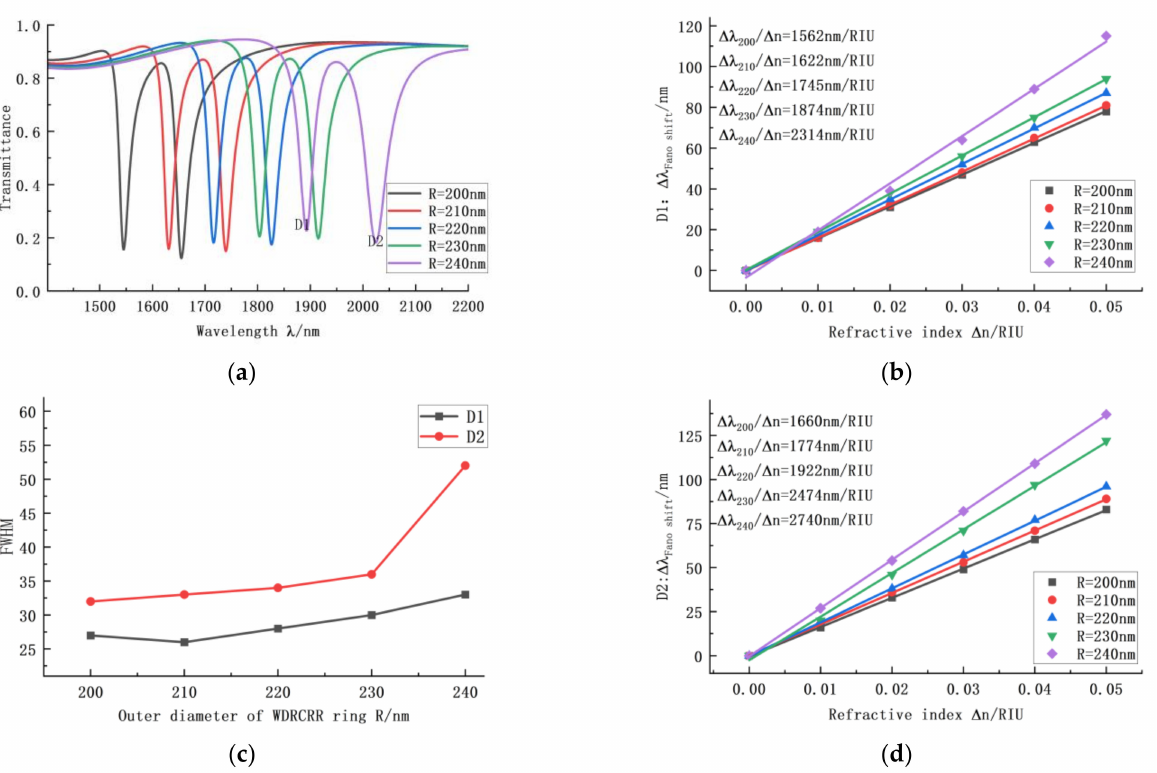
Figure 3. ( a ) Transmission curve spectrum when R is changed. ( b ) Sensitivity of the fit to the D1 trough as R changes. ( c ) Bandwidth plots corresponding to D1 and D2 when R is changed. ( d ) Sensitivity of the fit to the D2 trough as R changes.